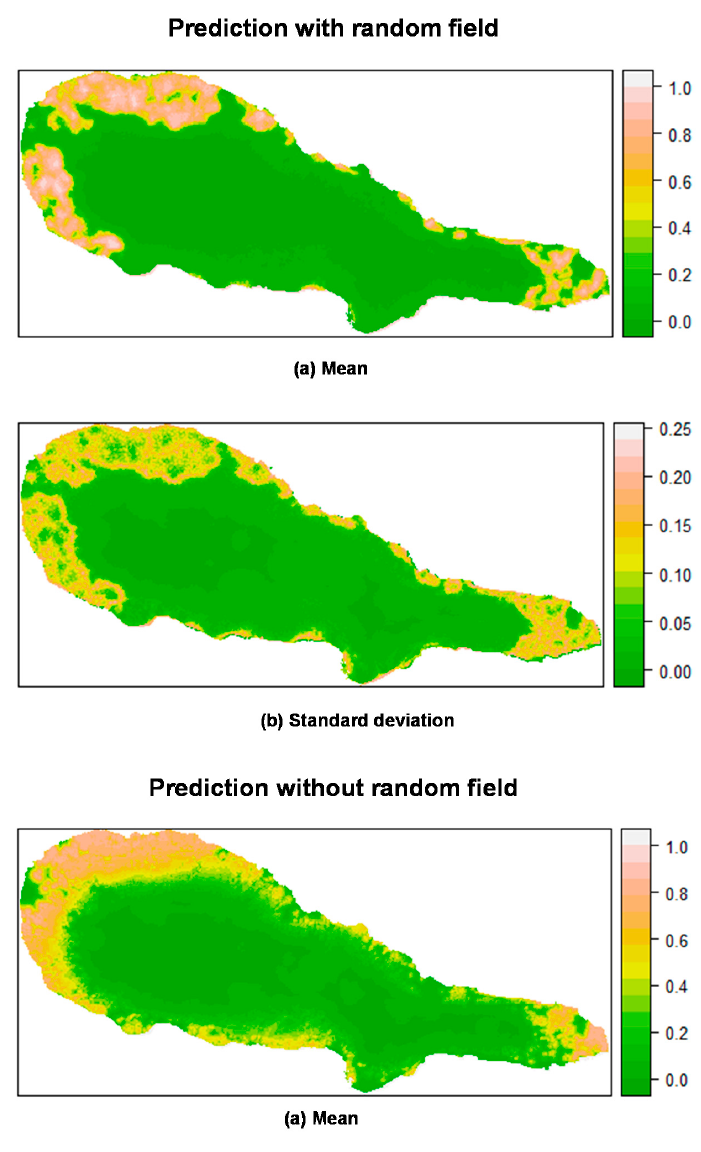
Figure 5. Prediction of P. undulatum occurrence in Pico Island by posterior mean ( a ) and standard deviation ( b ) of the linear predictor. Top: Mixed effects model including a random field; Bottom: Fixed effects model (without a random field). All models calculated using INLA.